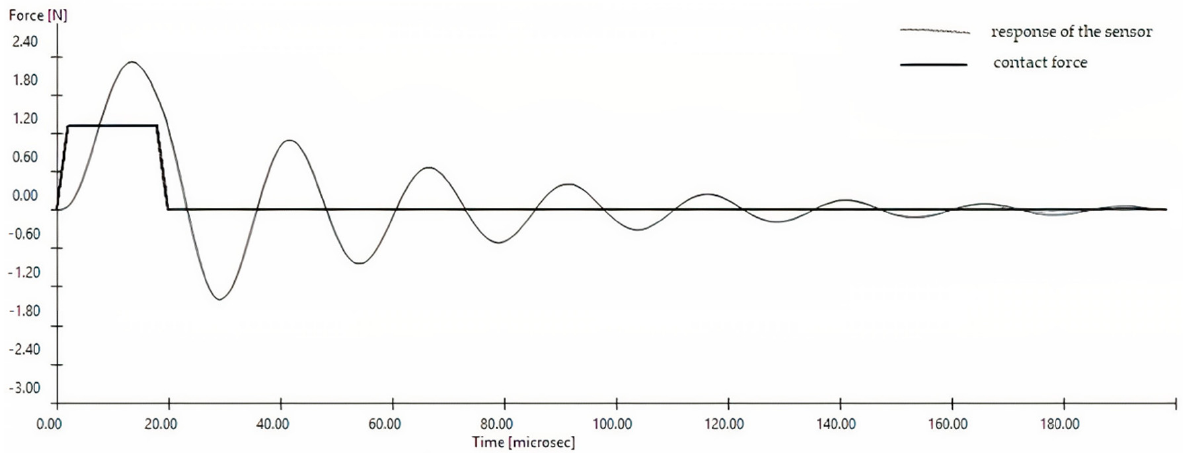
Figure 9. The course of the impact force and measurement signal from the sensor for small hard grains and the perfectly plastic model. Contact stiffness k 2 = 1 × 10 5 Nm − 1 , f rez = 40 kHz.